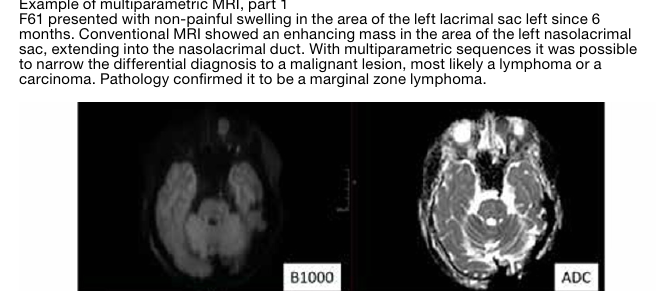
Figure 1: Sinonasal polyposis pattern (a) Axial CT (bone): Opacified left sphenoid and ethmoid sinuses, with left sphenoethmoidal recess obstruction. (b) Axial CT (soft tissue): Left choanal mucoid density mass extending into the ipsilateral maxillary sinus through a widened ostium. Figure 2: Sphenoethmoidal recess pattern (a) Axial CT (soft tissue): Opacified right sphenoid sinus with hyperdense content protruding into sphenoethmoidal recess. (b) MR: Heterogenous signal with convoluted appearance filling the right sphenoid sinus on T2WI. Figure 3: Ostiomeatal unit pattern (a) Coronal CT (bone): Opacification of the right maxillary sinus, frontal sinus, and anterior ethmoid air cells. (b) MR T2WI: Marked circumferential T2-weighted mucosal thickening, with expansion medially into the middle meatus and Figure 4: “Pitfall” (a) Axial CT (soft tissue), imaged for unrelated condition: Opacified right maxillary sinus with hyperdense material. Reported differential of fungal sinusitis (b) Coronal CT (bone): Odontogenic breach of right maxillary cortex. Note the patent middle meatusus. (c) Axial CT (bone): periapical lucency of upper right 7th molar. Example of multiparametric MRI, part 2